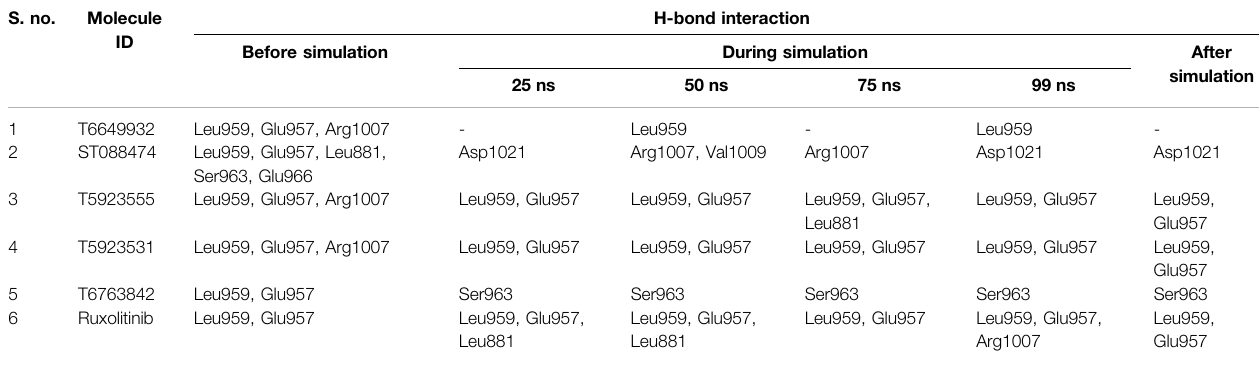
TABLE 11 | The protein – ligand interaction analysis of the selected JAK1 lead compounds and the drug before, during, and after MD simulation. S.